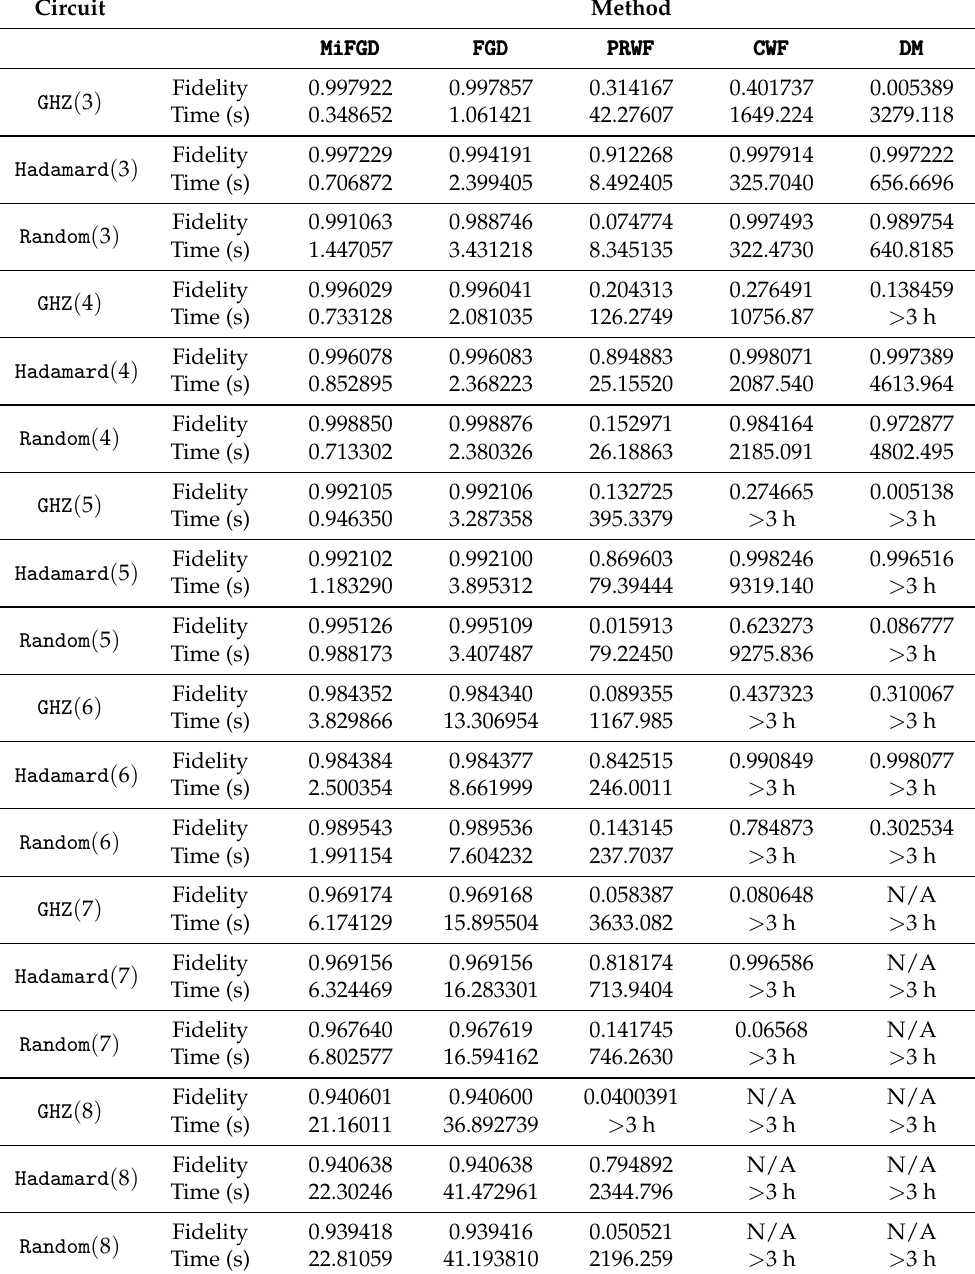
Table 4. Fidelity of reconstruction and computation timings using measpc = 50% and shots = 2048. Rows correspond to combinations of number of qubits (3 and computation time. For MiFGD , η = 0.001, µ = 3 “N/A” indicates that the method could not complete a single epoch in 3 h training time limit, and thus could not provide any fidelity result. All experiments are run on a NVidia GeForce GTX 1080 TI, 11 GB